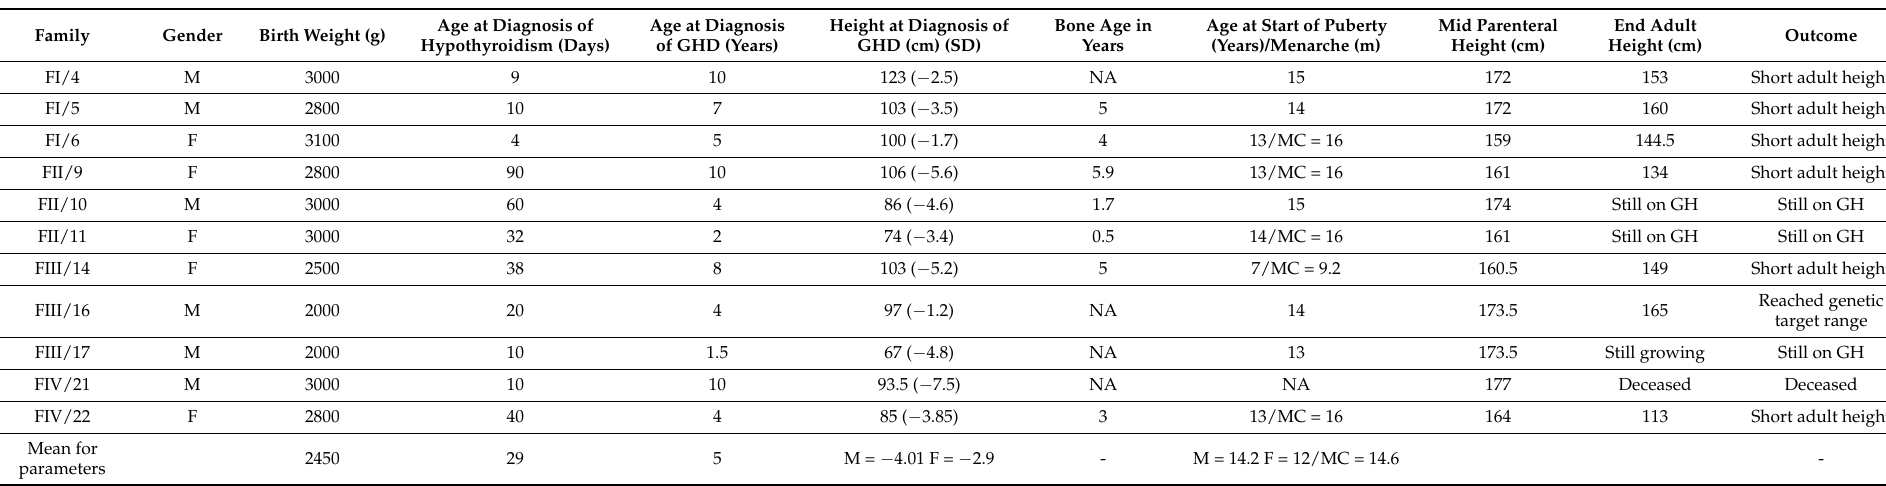
Table 1. Selected clinical characteristics of patients with combined pituitary hormone deficiency: GH, growth hormone; GHD, growth hormone deficiency; M, male; F, female; MC, menstrual cycle; SD, standard deviation; NA, not